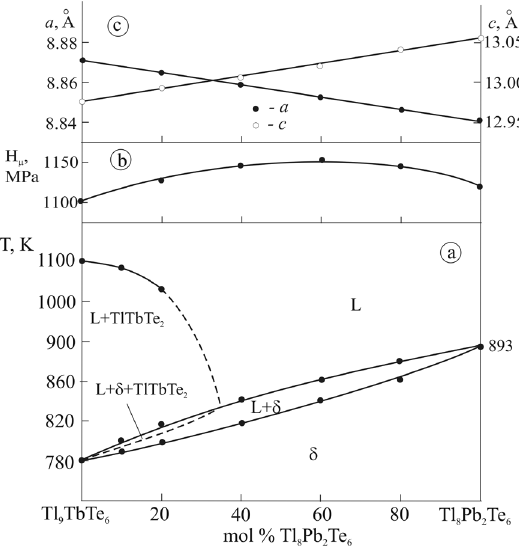
Figure 1. Phase diagram (a), concentration dependencies of microhardness (b), and lattice parameters (c) for the alloys of the TbTe -2Tl PbTe section. Tl 9 6 4 3